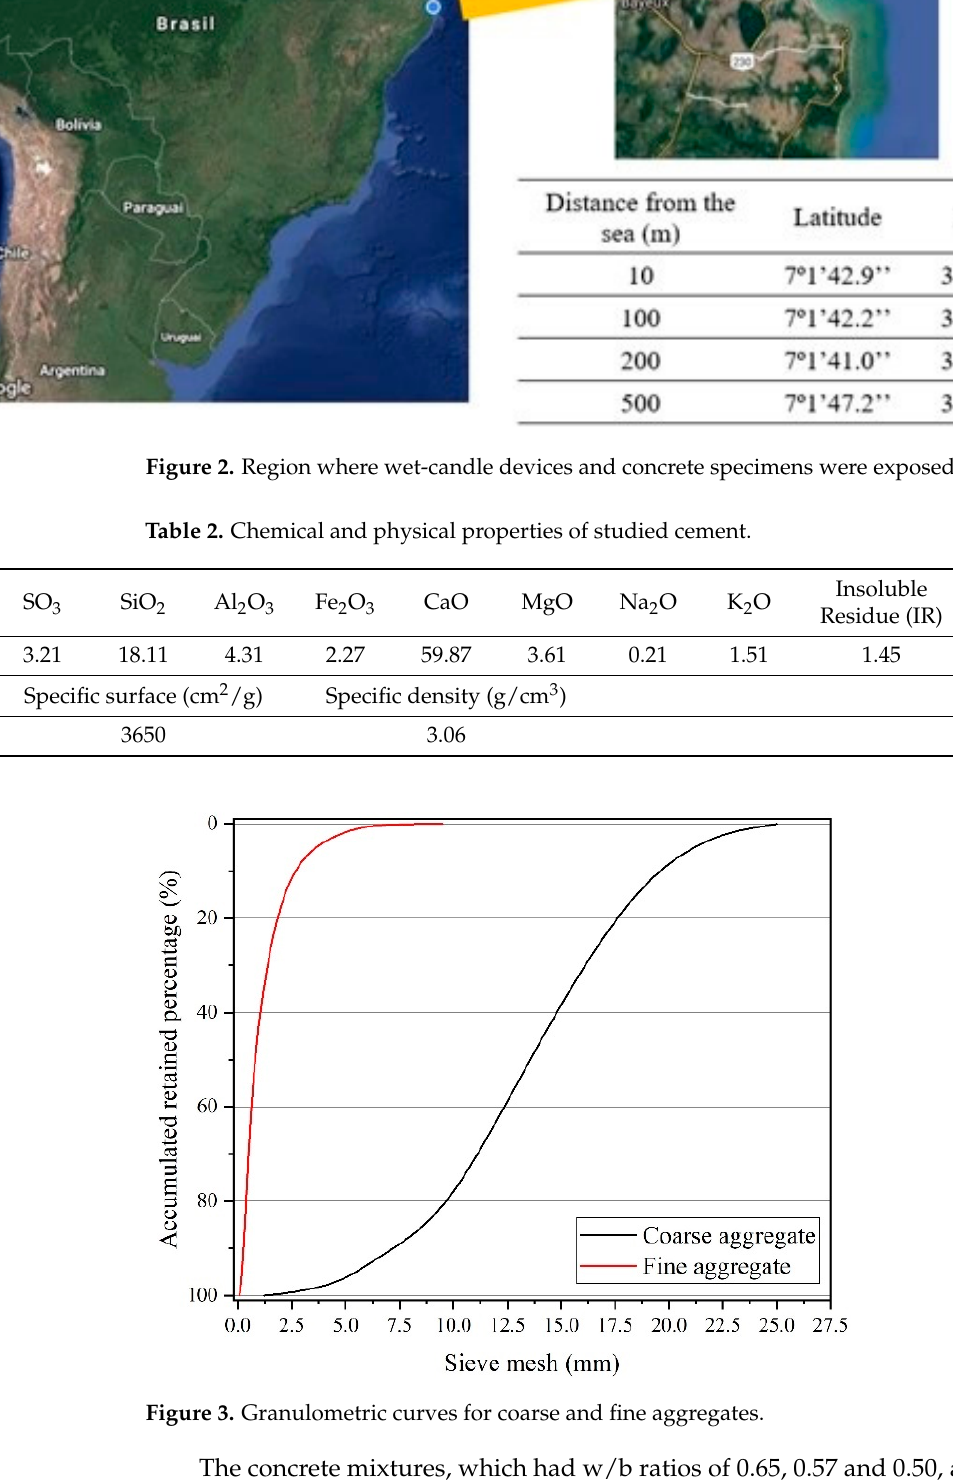
Table 3. Concrete mixtures and properties. Concrete